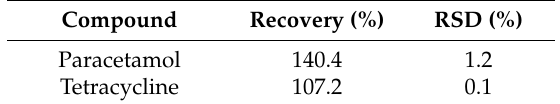
Table A1. Recoveries of paracetamol and tetracycline in zebrafish larvae 4 days post-fertilization (dpf).